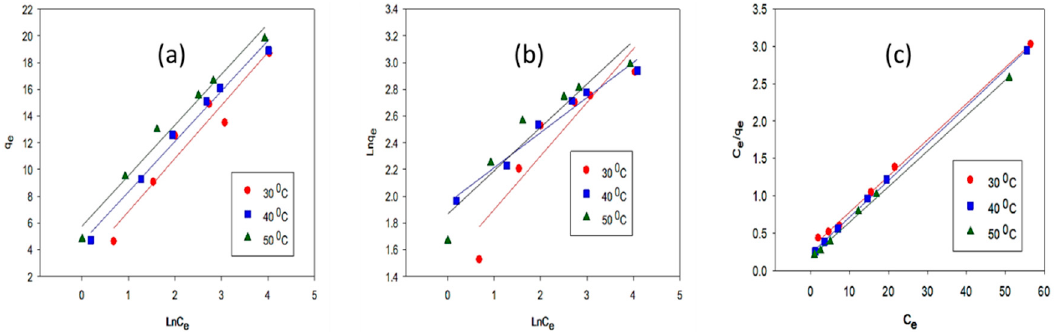
Figure 7. Linear Regression Analysis of ( a ) Langmuir, ( b ) Freundlich, and ( c ) Temkin Isotherm model at different temperature for LFP-300.